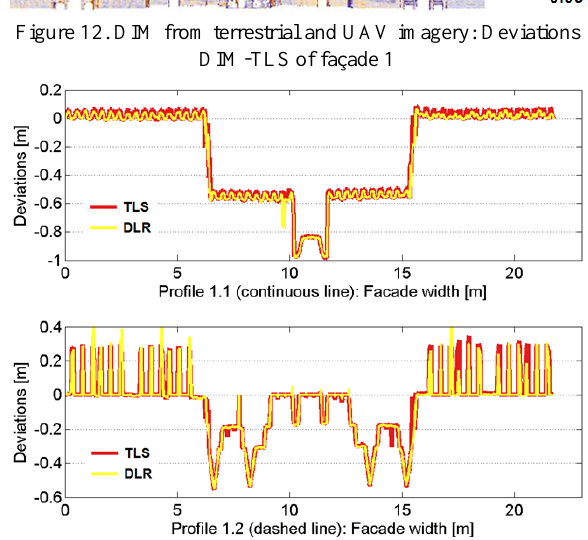
Figure 13. DIM from terrestrial and UAV imagery: Horizontal profiles of façade